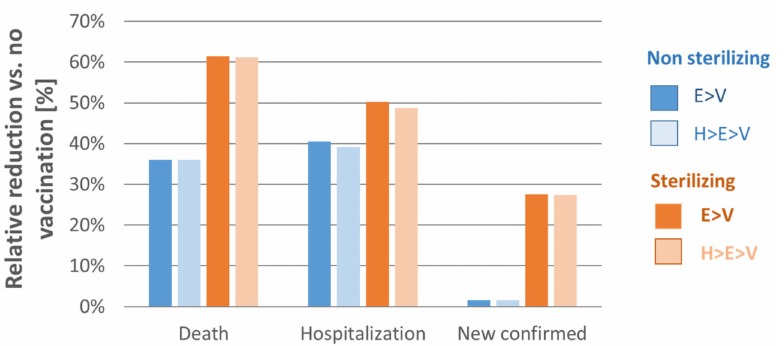
Figure 2. Total impact of vaccinating 2.45 million individuals on relative reductions in deaths, hospitalizations, and new confirmed infections. Crit.—critical, E—elderly, HCW—healthcare workers, Hosp.—hospitalizations, V—vulnerable. E > V: starting with the elderly (age 65+; 1.45 million), followed by vulnerable individuals (1 million) with increased risk of severe disease once infected. H > E > V: starting with healthcare workers (0.2 million), followed by the elderly (1.45 million) and then vulnerable individuals (0.8 million). Analysis assumed vaccine effectiveness to be 70% in the general population and 60% in the age group 65+. Optimal vaccination strategies were determined by maximizing relative reduction of death and